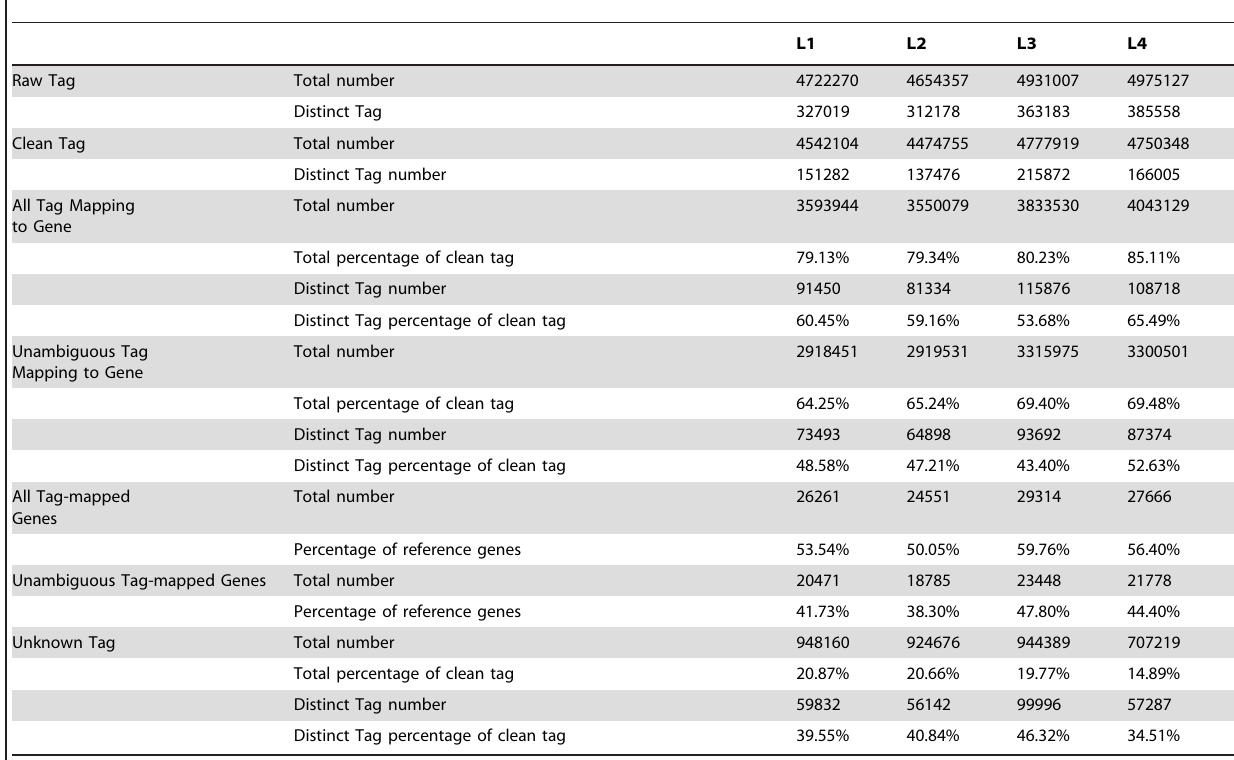
Table 2. Categorization and abundance of